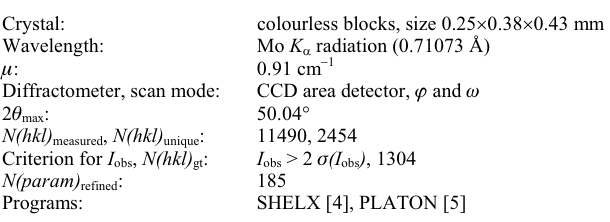
Table 1. Data collection and handling.